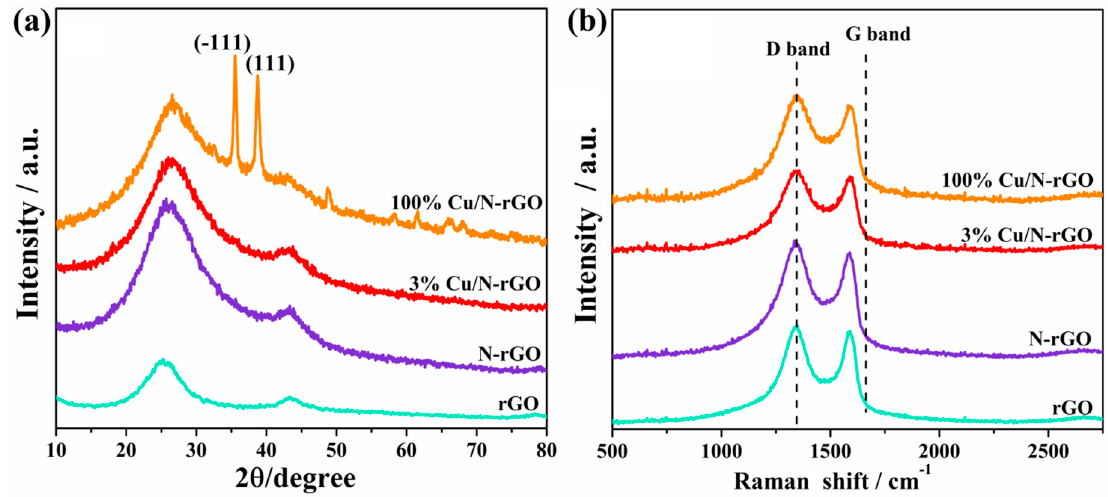
Figure 2. ( a ) XRD patterns and ( b ) Raman spectra of rGO, N-rGO, 3%Cu / N-rGO, and 100%Cu /